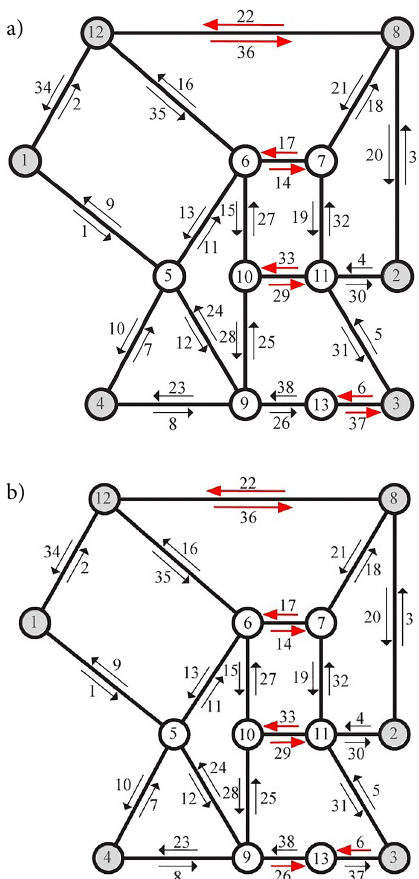
Figure 3. Results obtained by applying models on the Nguyen–Dupuis network: a – results of Model